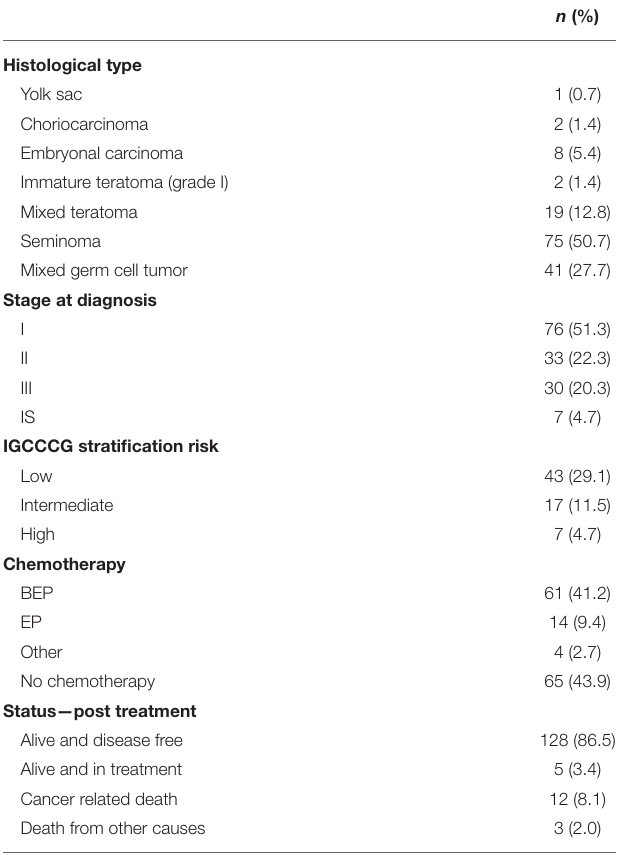
TABLE 1 | Clinicopathological characteristics of adult testicular germ cell tumor